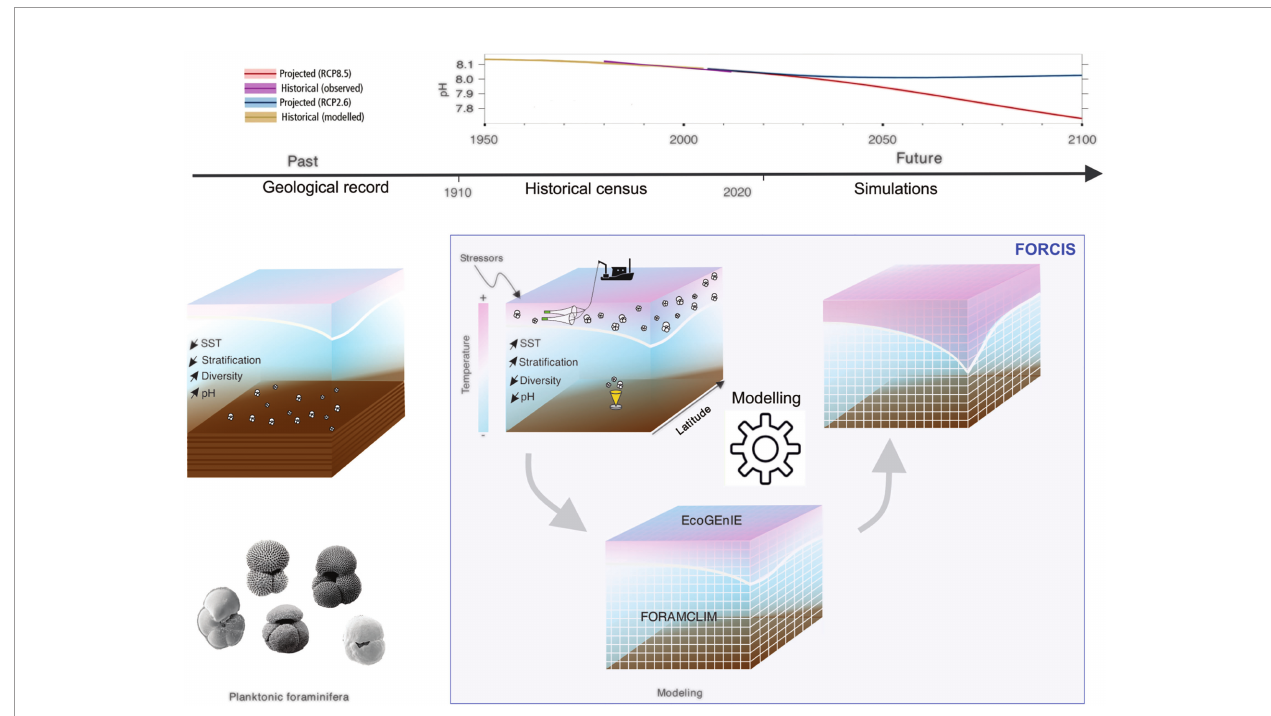
FIGURE 1 | The FORCIS project compiles planktonic Foraminifera census data, analyzes the trends and their links to environmental changes, from historical and future changes in environmental parameters such as pH [top panel, scenario SRES 8.5 & 2.5 – (IPCC, 2019)], and uses those constraints to calibrate models that will be further used for simulations of their past and future distribution